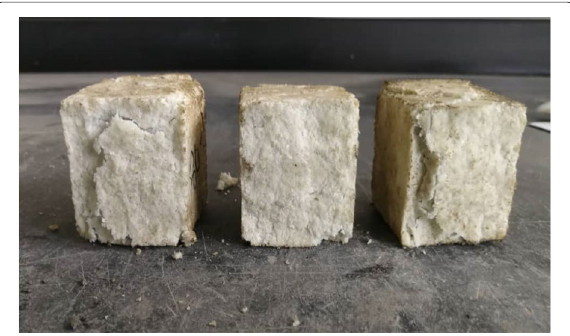
Fig. 4 Compressive strength samples after